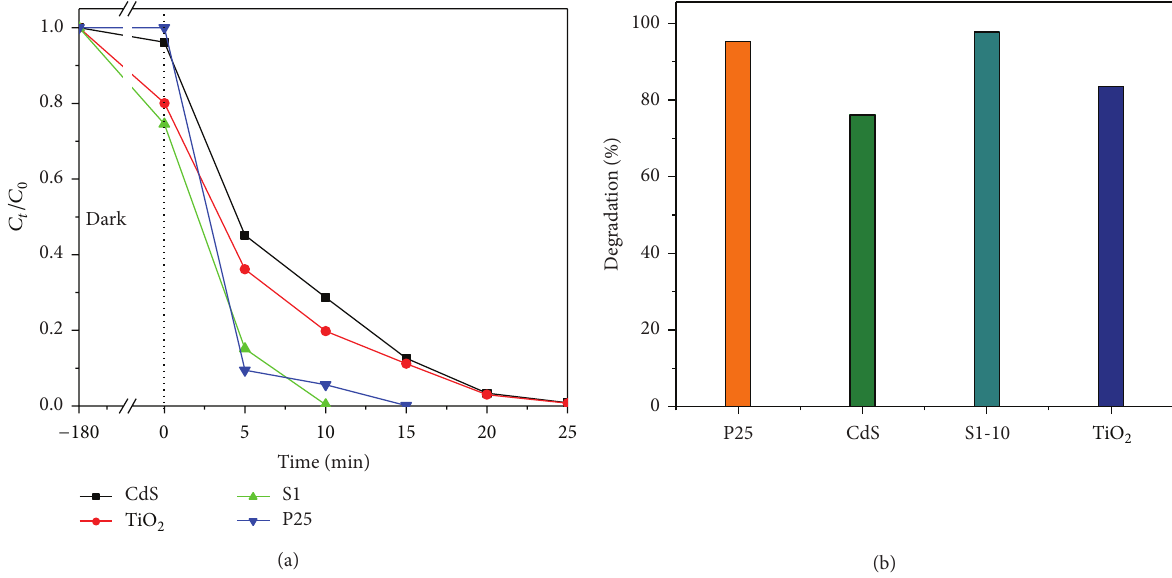
Figure 2: (a) 𝐶 𝑡 /𝐶 0 versus time curves of RhB photodegradation under simulated sunlight irradiation by CdS, S1-10: 10wt% TiO 2 /CdS (10h), TiO 2 , and P25, respectively. (b) Comparison of the photocatalytic activity of P25, CdS, S1-10: 10wt% TiO 2 /CdS (10h), and TiO 2 , respectively, in